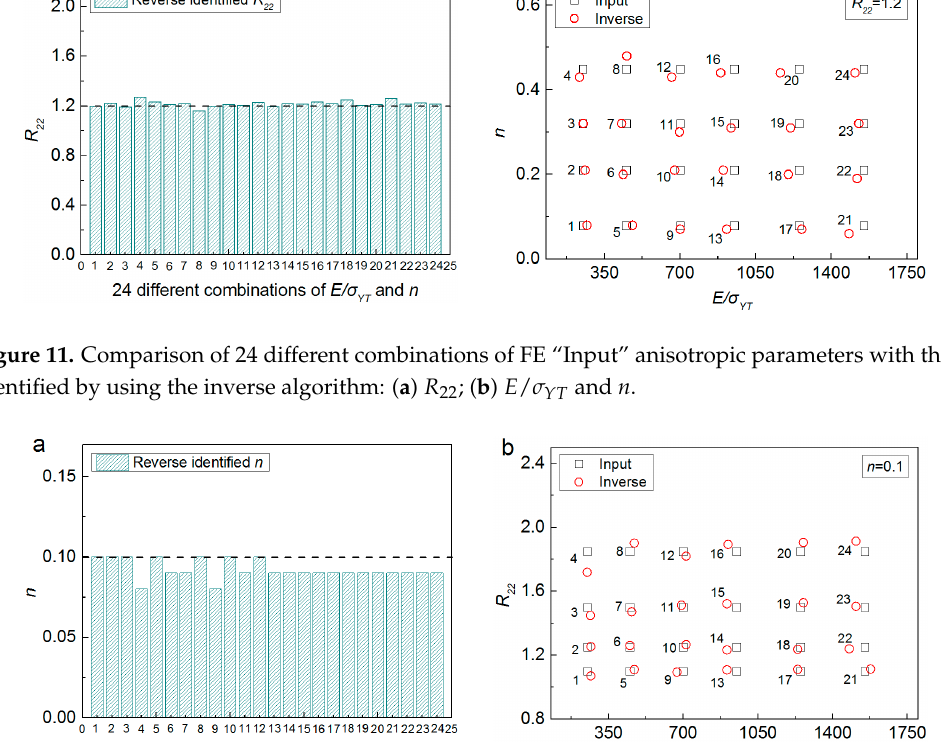
Figure 12. Comparison of 24 different combinations of FE “Input” anisotropic parameters with those identified by using the inverse algorithm: ( a ) n ; ( b ) E / σ YT and R 22